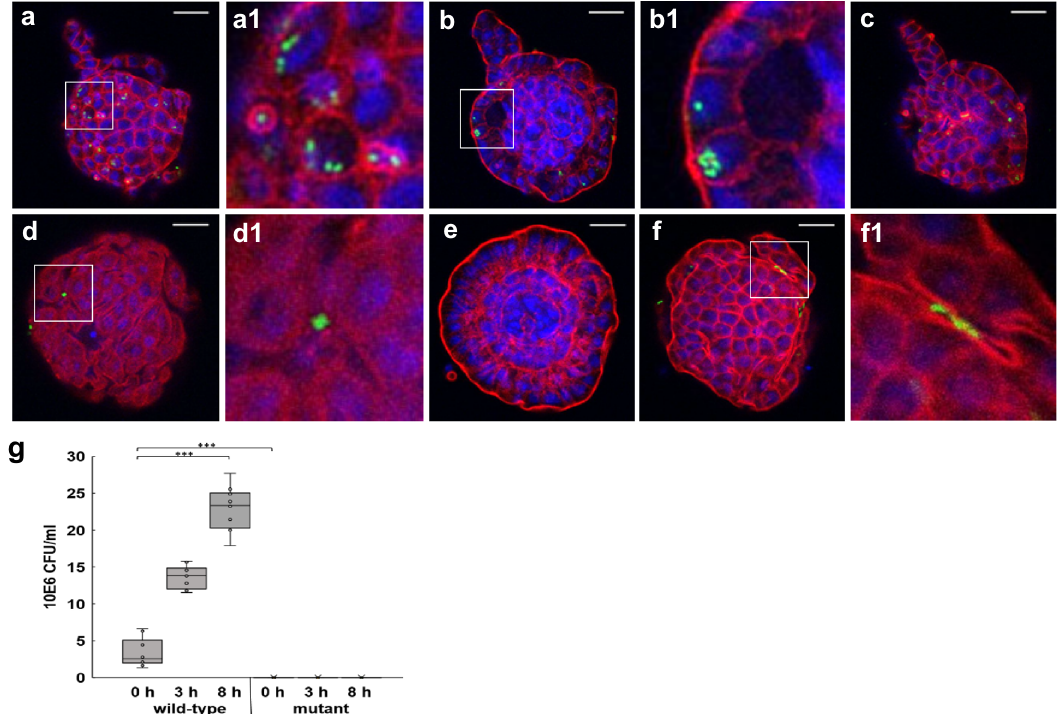
Fig. 8 Chicken enteroids as a model for host – bacterial interactions. a – f Representative z-axis projections of chicken enteroids 2 days in culture whole- mount stained to detect cell nuclei (DAPI, blue) and F-actin-expressing brush border (red). Enteroids incubated with a – c wild type S . Typhimurium-GFP (green) and d – f mutant non-invasive S .Typimurium-GFP (green) at 4h. Magni fi ed images of a1 actin remodelling, b1 intracellular bacteria and d1 , f1 lack of actin remodelling and intracellular bacteria. Images are representative of data from at least 3 independent cultures each containing 2 – 3 embryos. Scale bar: 20 µ m. g Bacterial net replication assay con fi rmed Salmonella counts were signi fi cantly increased for enteroids infected with wild-type versus mutant Salmonella strains. Box and whisker plot represent bacterial count from ~800 infected enteroids post high-dose gentamicin treatment. Data derived from 5 independent experiments with 2 – 3 embryos per culture. *** p <0.0002, W = 55, 95.5% CI for n1 – n2 is ( − 419850, − 189760) using a Mann – Whitney U -test (two-sided). The assay also showed wild-type Salmonella replicated in the enteroids over 0 – 8h. *** p <0.0001, R 2 = 0.73, df = 29 using a linear regression test.